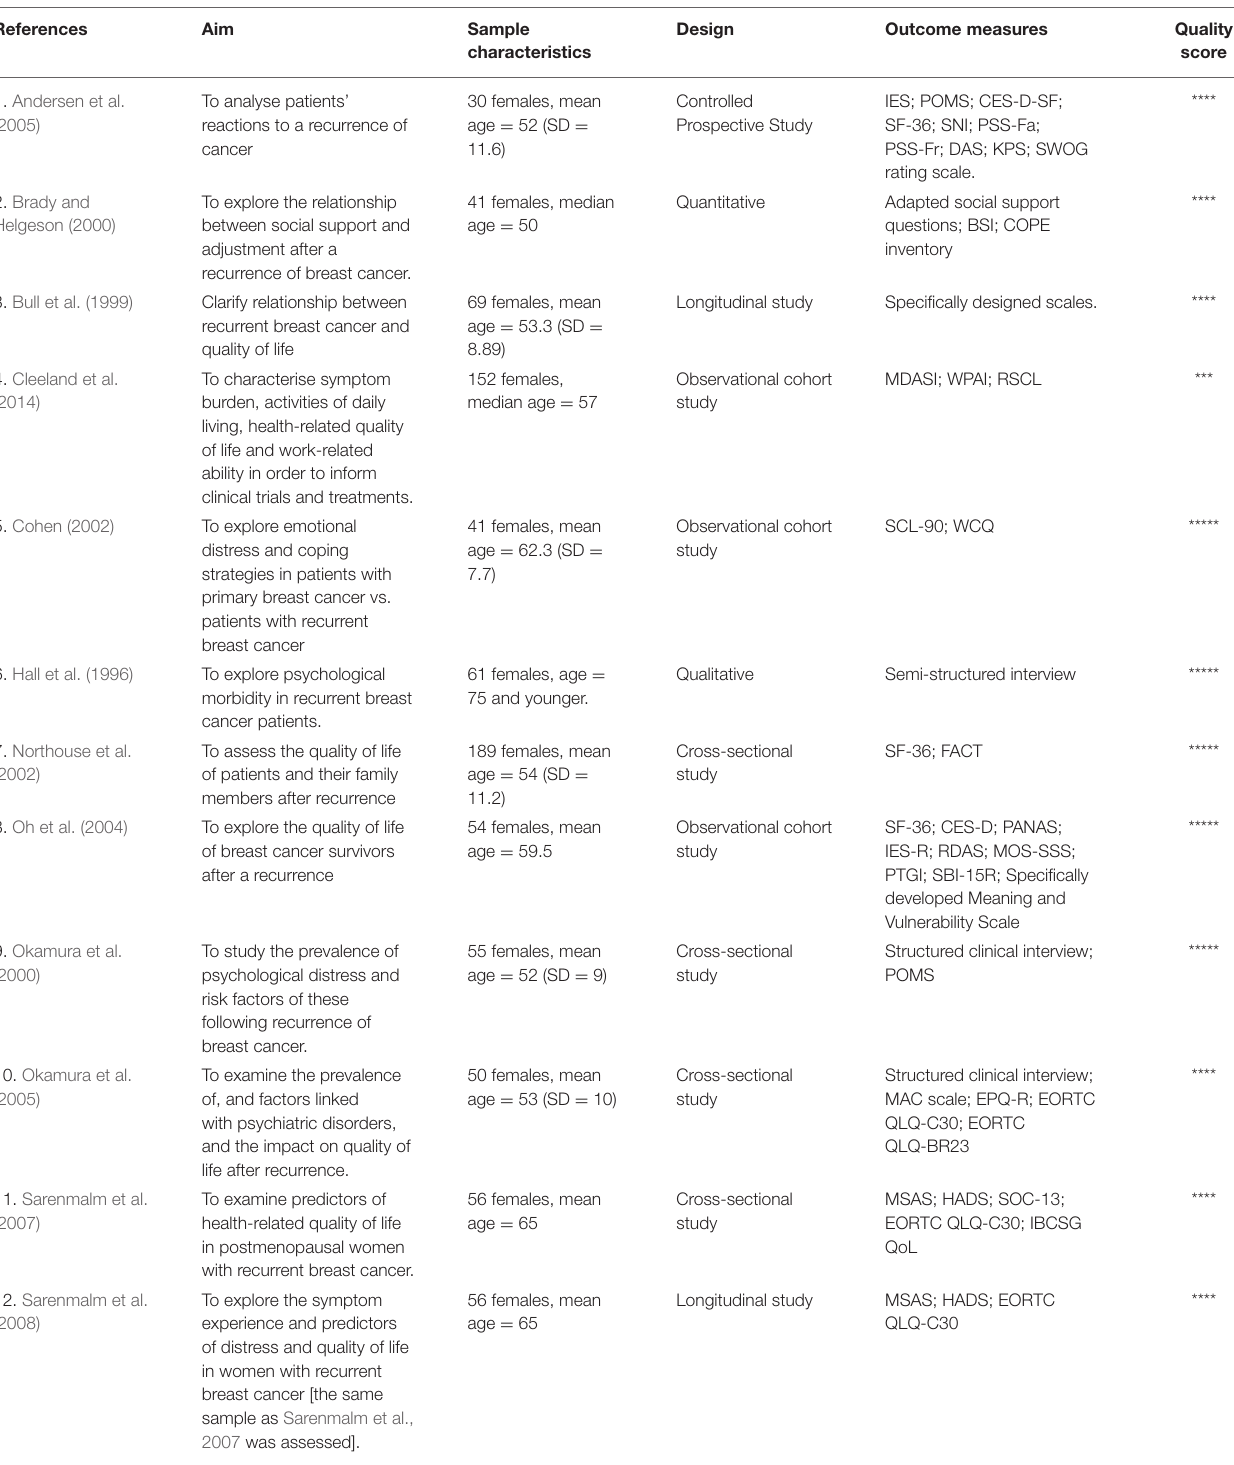
TABLE 1 | Breast cancer studies included in